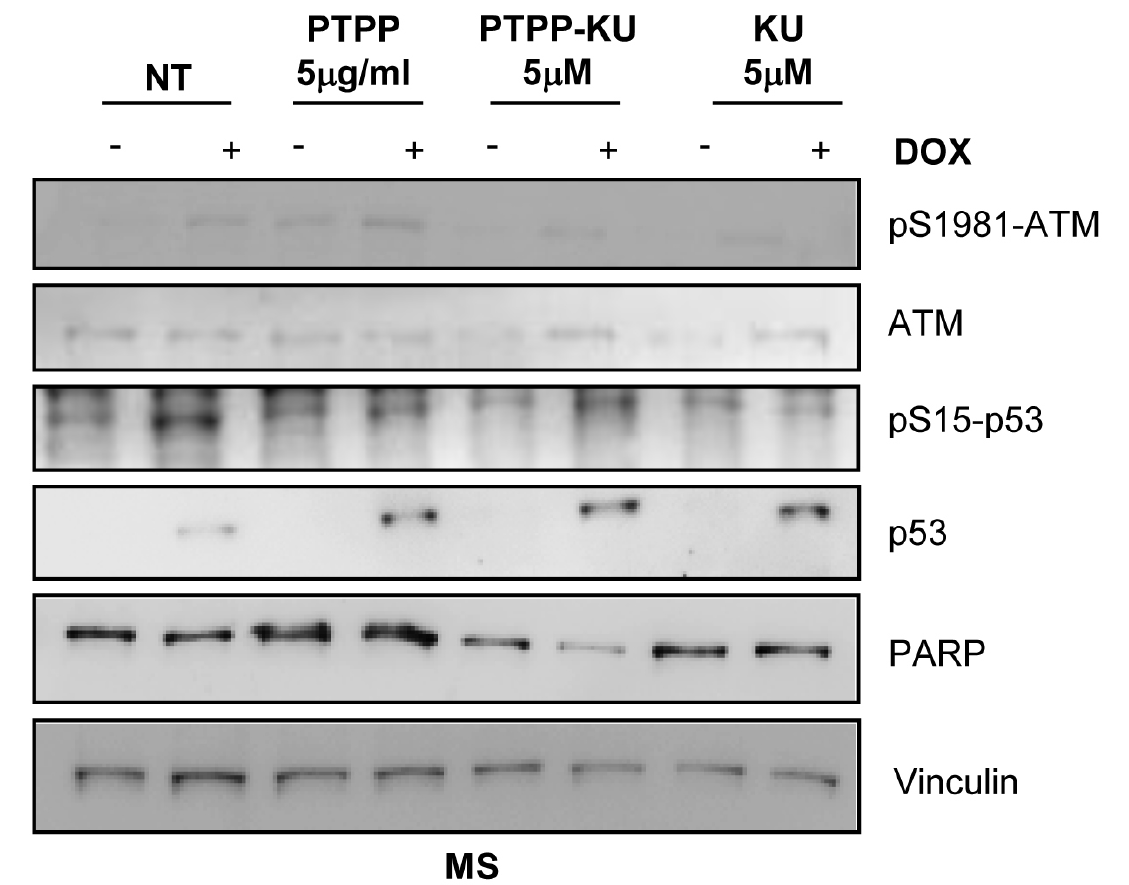
Figure 4. ATM activation and apoptosis induction in mammospheres co-treated with DOX and PTPP–KU. Representative Western blot of total protein extracts, performed after 24 h, from mammospheres derived from MCF-7 cells treated with DOX (1 µ M) for 3 h and immunoblotted for the indicated antibodies ( n = 3).